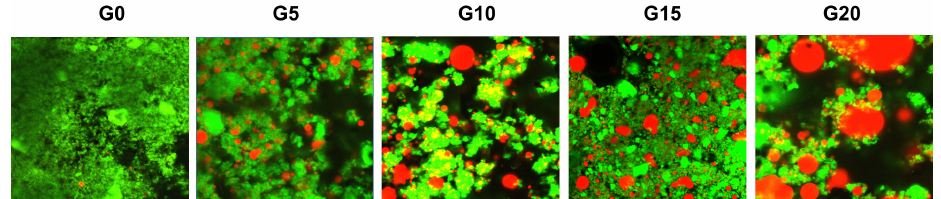
Figure 9. Confocal micrographs of fermented PPI gels after 7 days of storage under refrigeration in closed containers. Sample name corresponds to its oil content, e.g., G0: 0% oil, G5: 5% oil, etc. Proteins are represented in green and oil droplets in